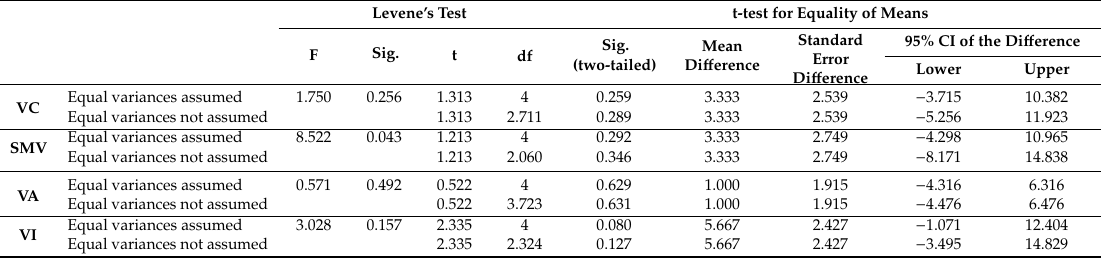
Table 6. Test applied to the control group.